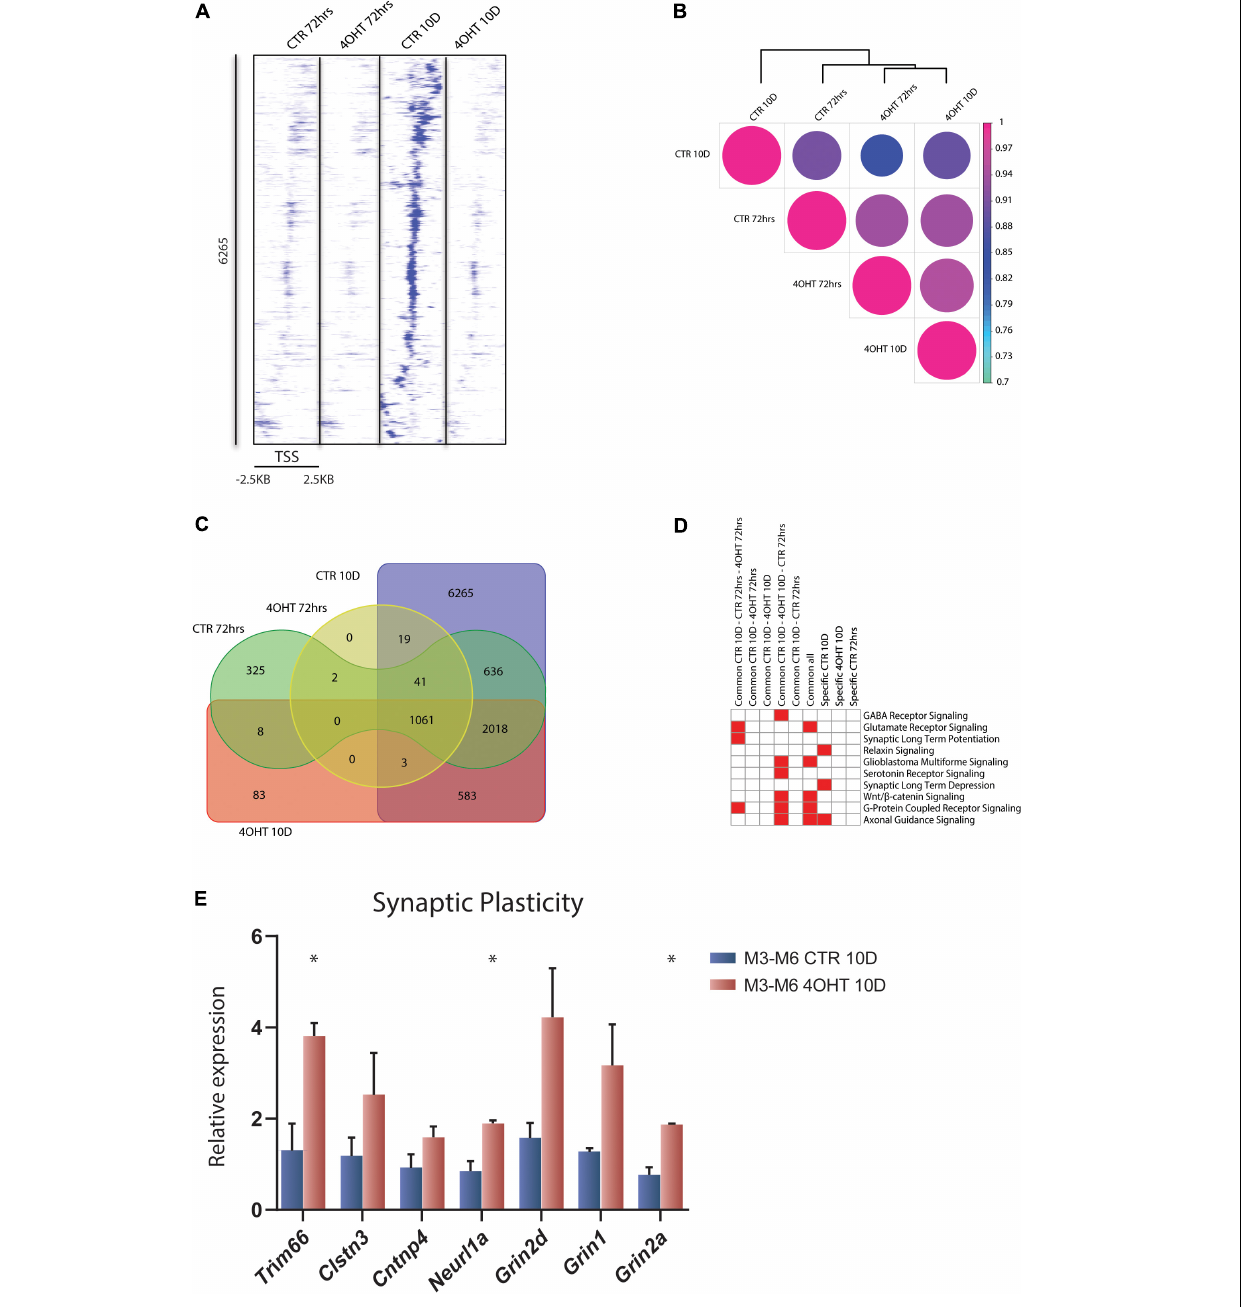
Frontiers in Neuroscience |